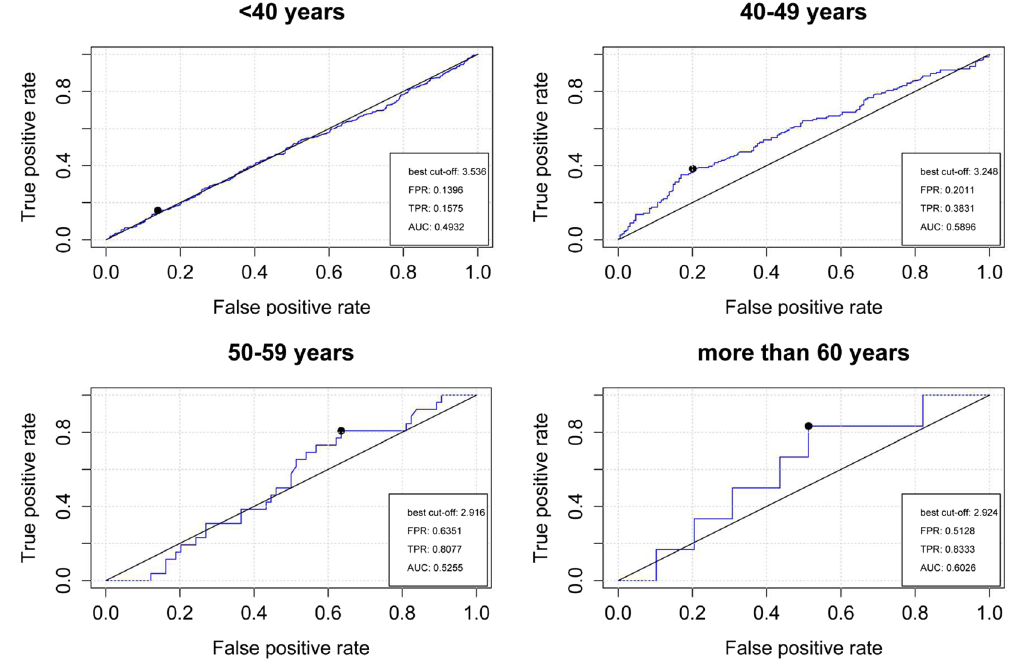
Figure 1. Relative operating characteristic (ROC) curve analyses of osteocalcin in predicting the ED risk in four different age groups ( < 40, 40–49, 50–59 and ≥ 60 years). The Best cut-off, area under the curve (AUC), False Positive Rate (FPR) and True Positive Rate (TPR) are shown in the